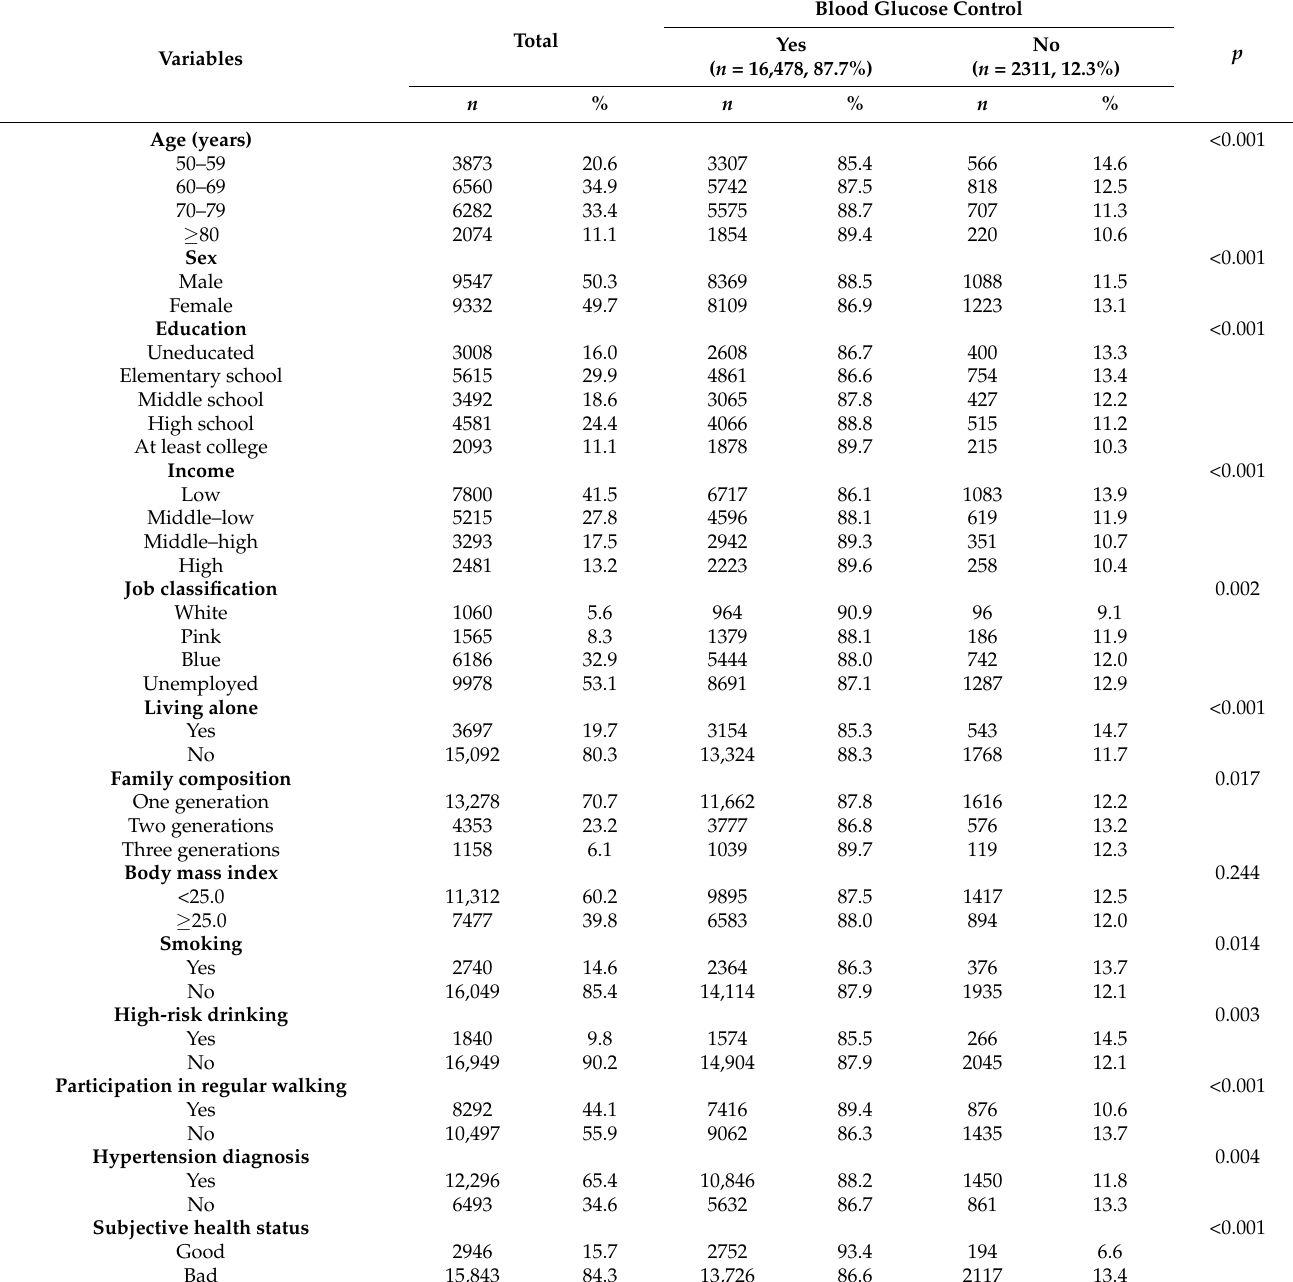
Table 1. Characteristics of the study participants ( n =